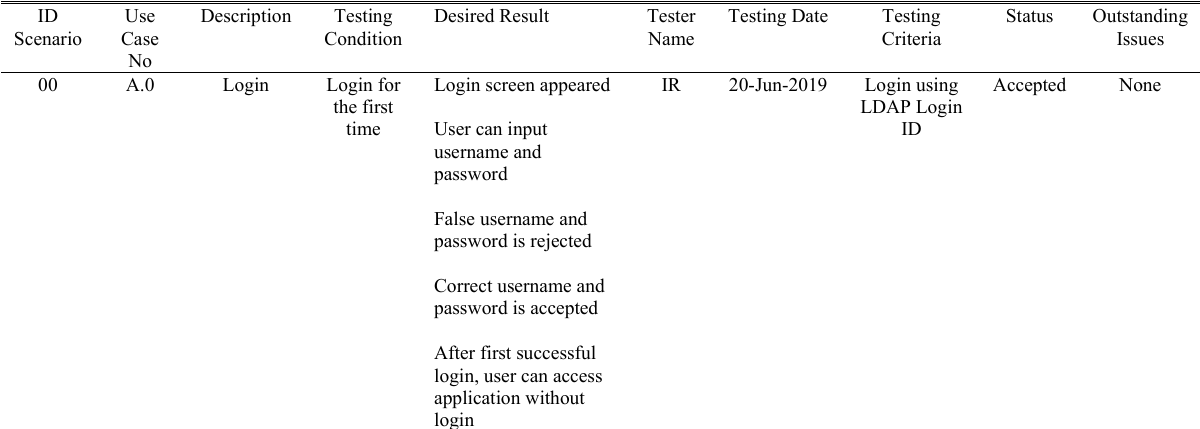
TABLE 3 F RAGMENT O F T ESTING S CENARIO AND T ESTING R ESULTS